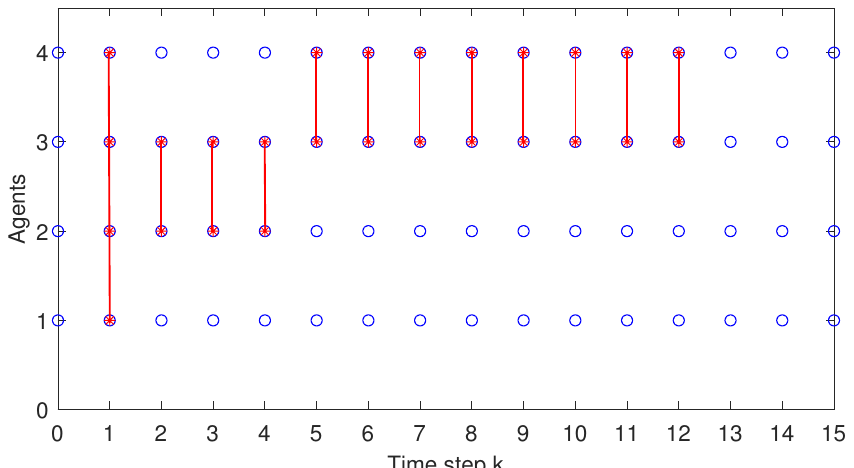
Figure 12. Test 4 —Coalitions formed at each time instant.